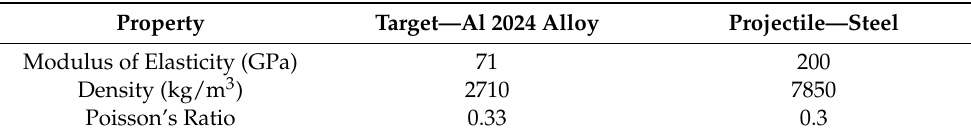
Table 4. Material properties of target and projectile used in LS DYNA